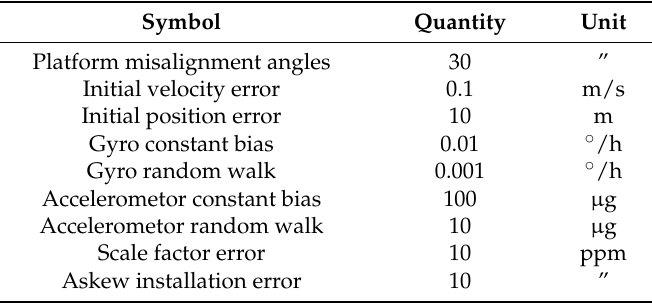
Table 2. Simulation condition of INS.